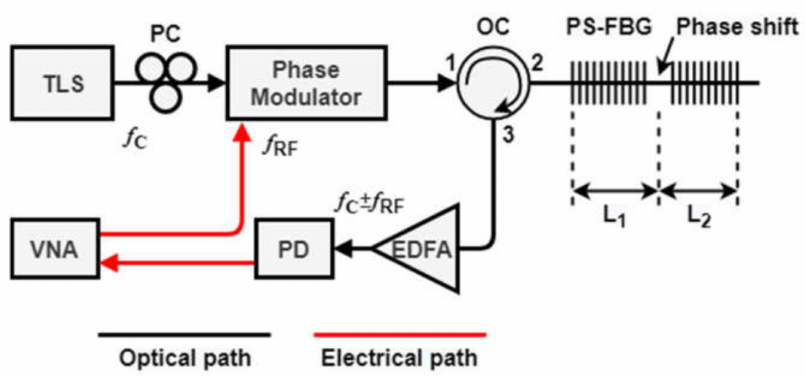
Figure 12. Schematic of a microwave photonics filter based on PS-FBG. TLS—Tunable laser source; PC—Polarization controller; OC—Optical circulator; PS-FBG—Phase-shifted FBG; EDFA—Erbium doped fiber amplifier; PD—Photodiode; VNA—Vector network analyzer (Adapted with permission from Ref [56]. Copyright 2012,